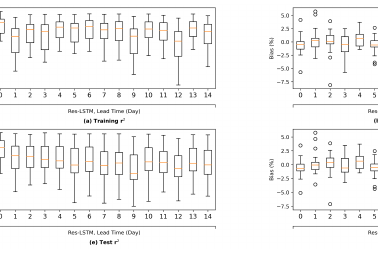
Figure 8. Salinity forecasting performance of